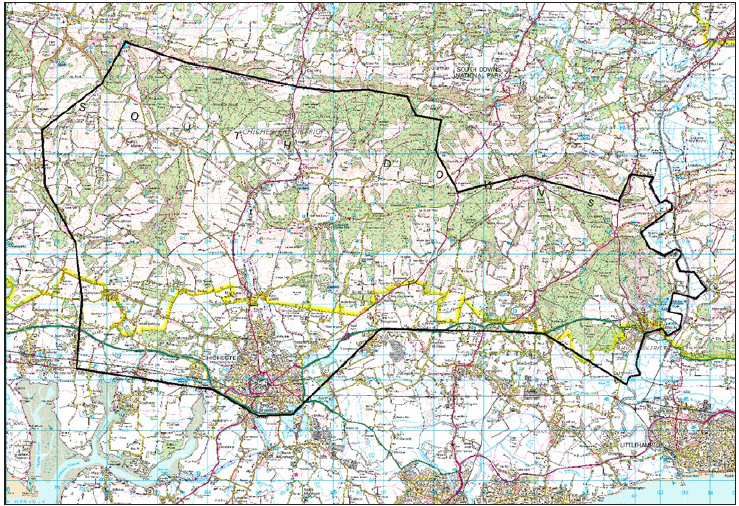
Figure 15: The bounds of the Forest of Arundel from Fitzalan Survey Book B (Clough 1969), drawn on an Ordnance Survey 1:50k basemap. [Base Image OS